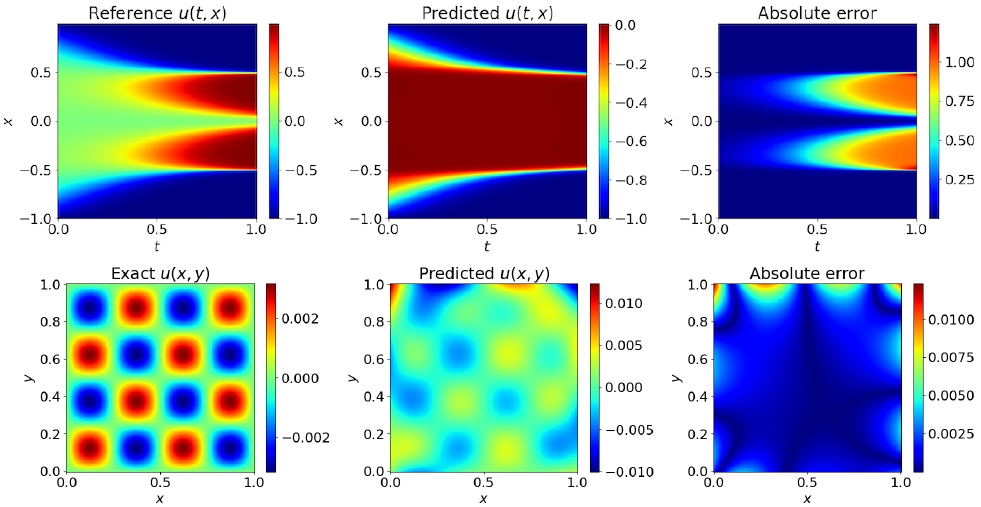
Figure 1. PINNs results for solving Allen–Cahn Equation (The first row) and 2D Poisson’s Equation (The second